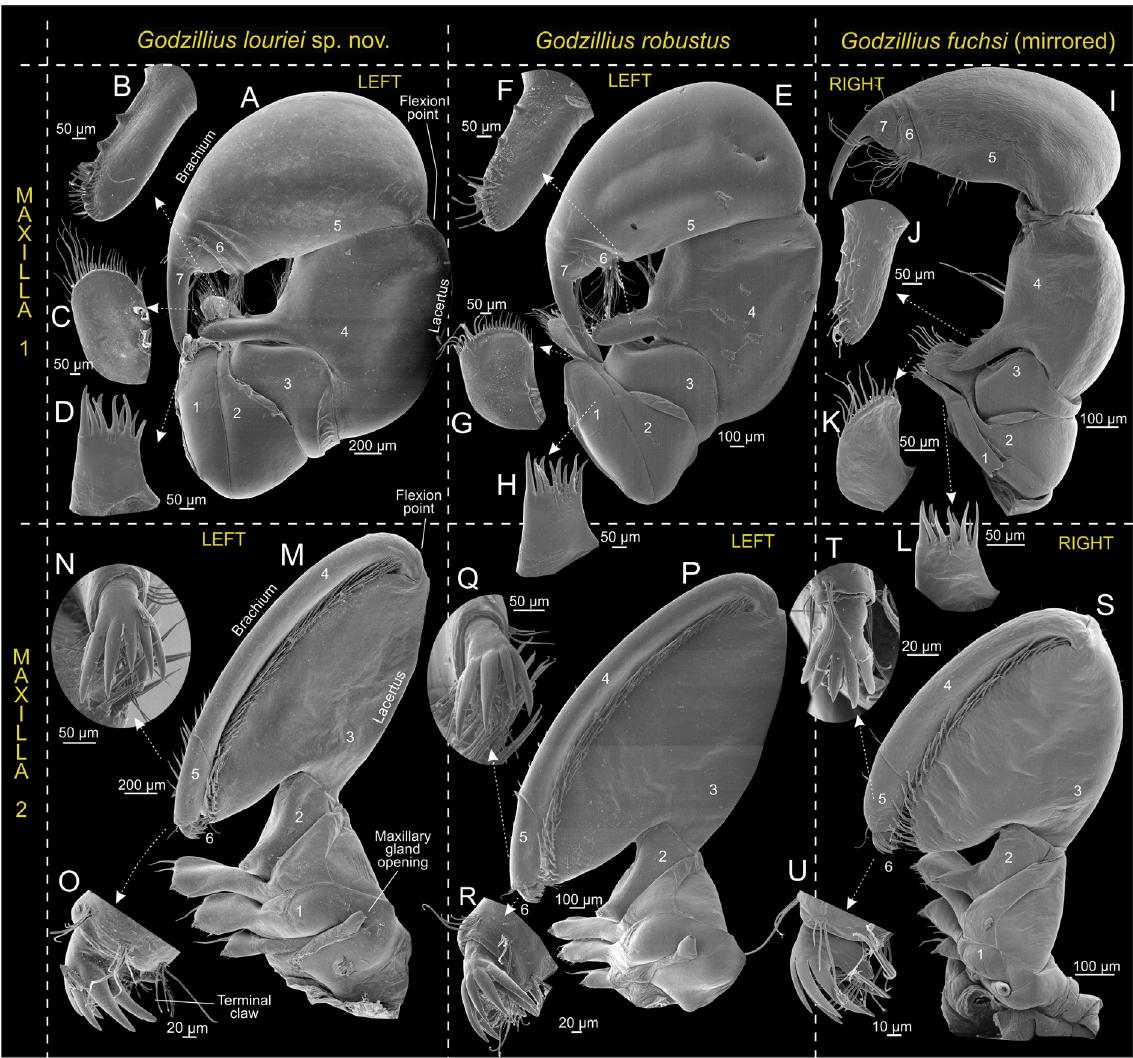
Fig. 9. Morphological comparison of maxilla 1 (mx1) and maxilla 2 (mx2) between Godzillius louriei sp. nov. (NHMD 669698) (A–D, M–O), G. robustus Schram, Yager & Emerson, 1986 (UNSM 1524349) (E–H, P–R) and G. fuchsi Gonzalez, Singpiel & Schlagner, 2013 (NHMD 165841) (I–L, S–U), scanning electron microscopy. A . Left mx1, posterior face. B . Digitiform endite on segment 4, posterior view. C . Spatulate endite of segment 2. D . Endite of segment 1. E . Left mx1, posterior face. F . Digitiform endite on segment 4, posterior view. G . Spatulate endite of segment 2. H . Endite of segment 1. I . Right mx1, posterior face (mirrored). J . Digitiform endite on segment 4, posterior view. K . Spatulate endite of segment 2. L . Endite of segment 1. M . Left mx2, posterior face. N . Apical view of terminal claw. O . Posterior view of terminal claw. P . Left mx2, posterior face. Q . Apical view of terminal claw. R . Posterior view of terminal claw. S . Left mx2, posterior face. T . Apical view of terminal claw. U . Posterior view of terminal claw. Small numbers represent segments of mx1 and